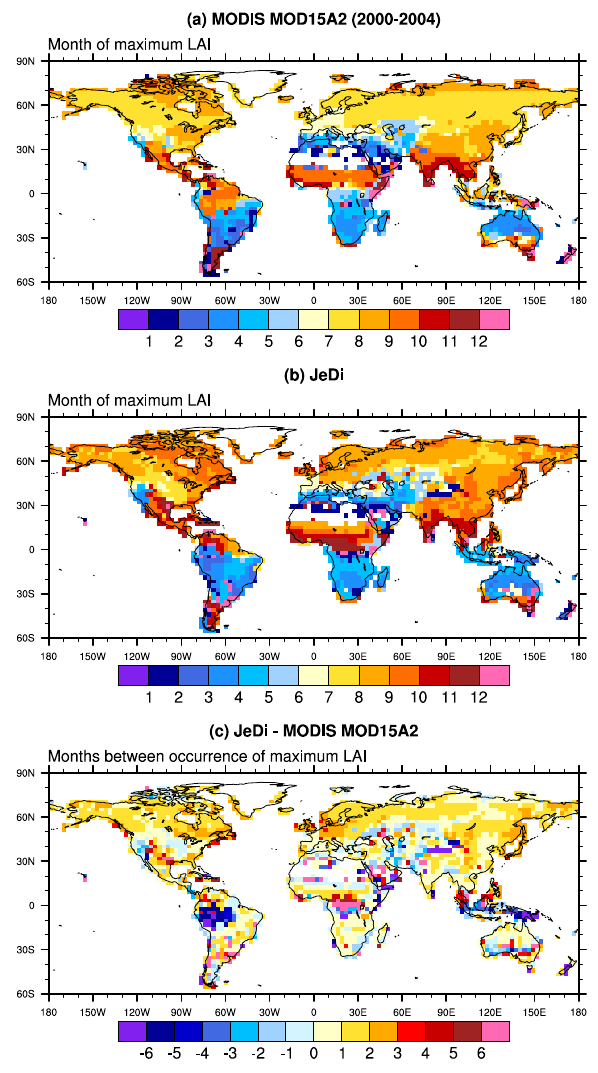
Fig. 2. Mean month of maximum leaf area index for years 2000– 2004 from (a) MODIS MOD15A2 Collection 4 LAI product ( My- neni et al., 2002; Zhao et al., 2005), (b) as simulated by JeDi- DGVM, and (c) the lag in months between the occurrence of max- imum LAI in the MODIS observations and the JeDi-DGVM model